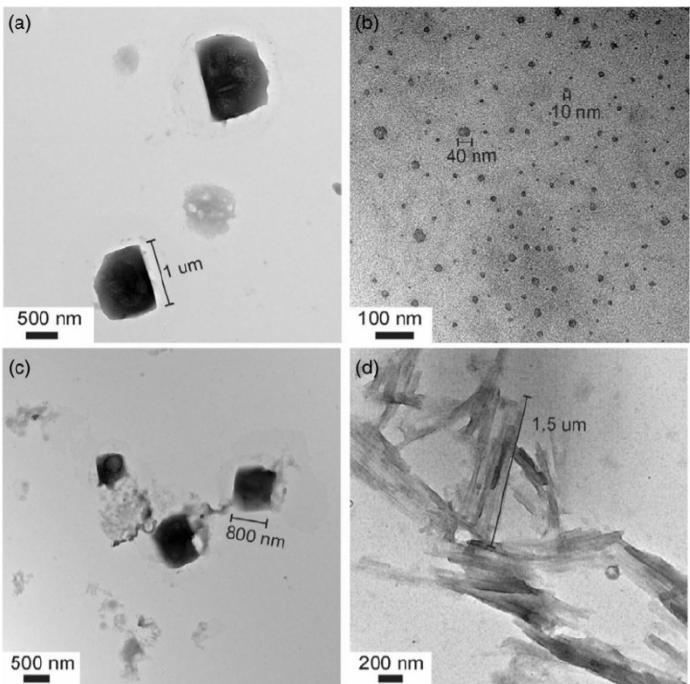
Figure 12. Representative TEM images of the NaBH 4 nanostructures of ( a ) NaBH 4 —isopropylamine, ( b ) NaBH 4 —tetrabutylammonium bromide, ( c ) NaBH 4 —octadecylamine and ( d ) NaBH 4 —tridecanoic acid. Reproduced with permission from [191].